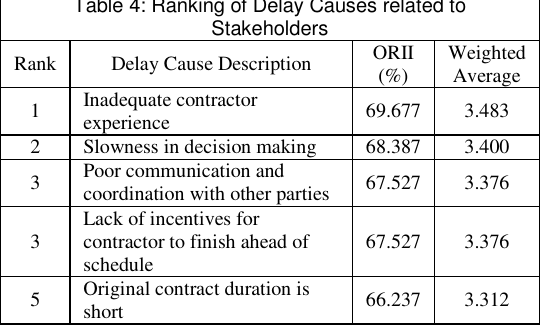
Table 6: Ranking of Delay Causes Related to